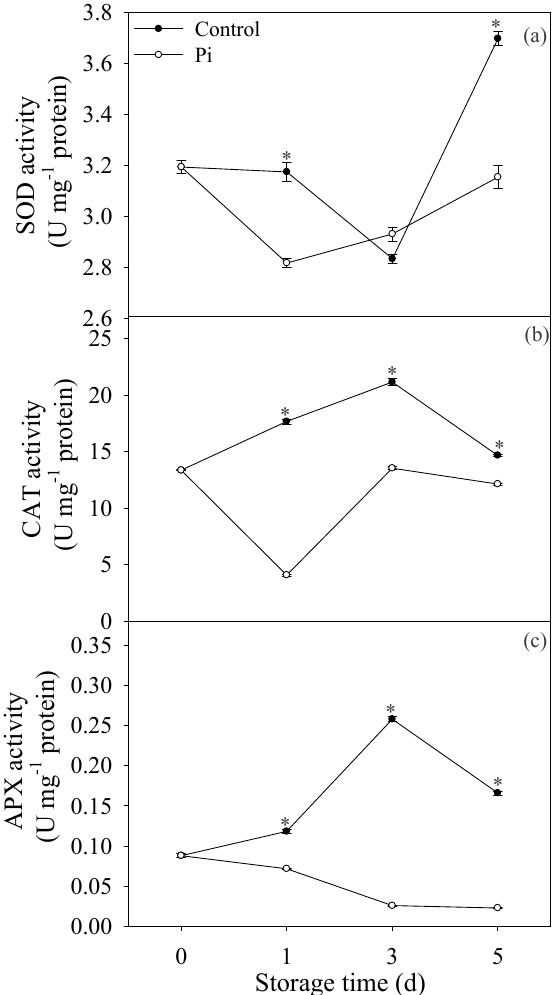
Figure 3. Effects of P. italicum infection on enzyme activity of superoxide dismutase (SOD) ( a ), catalase (CAT) ( b ), and ascorbate peroxidase (APX) ( c ) of mandarin peel during storage at 25 ◦ C. Each data point represents a mean of three replicate assays ± standard error. Asterisks at the same storage time represented the significant differences ( P < 0.05).